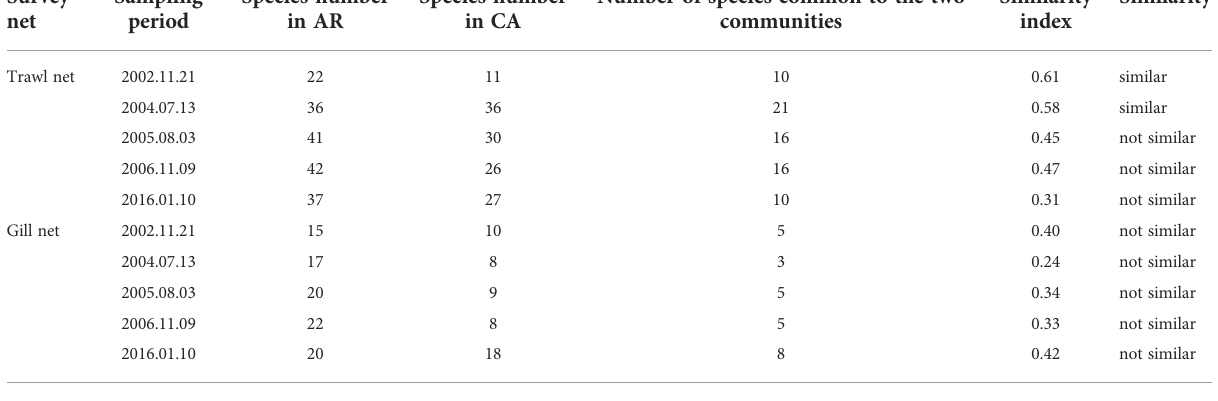
TABLE 3 Species and similarity index of nekton community in AR and CA habitats surveyed during trawl net and gill net sampling period.